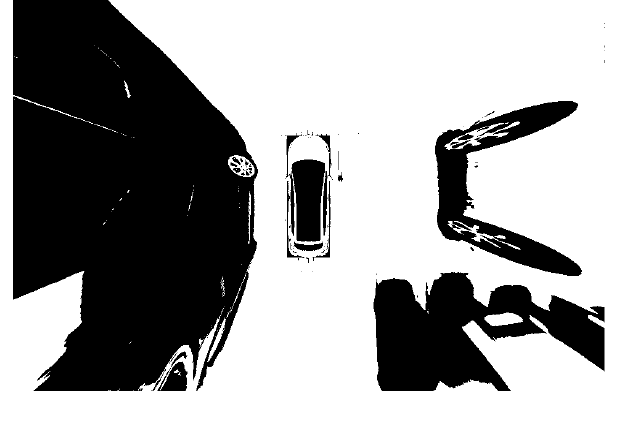
Figure 19. Grayscale and filtering.